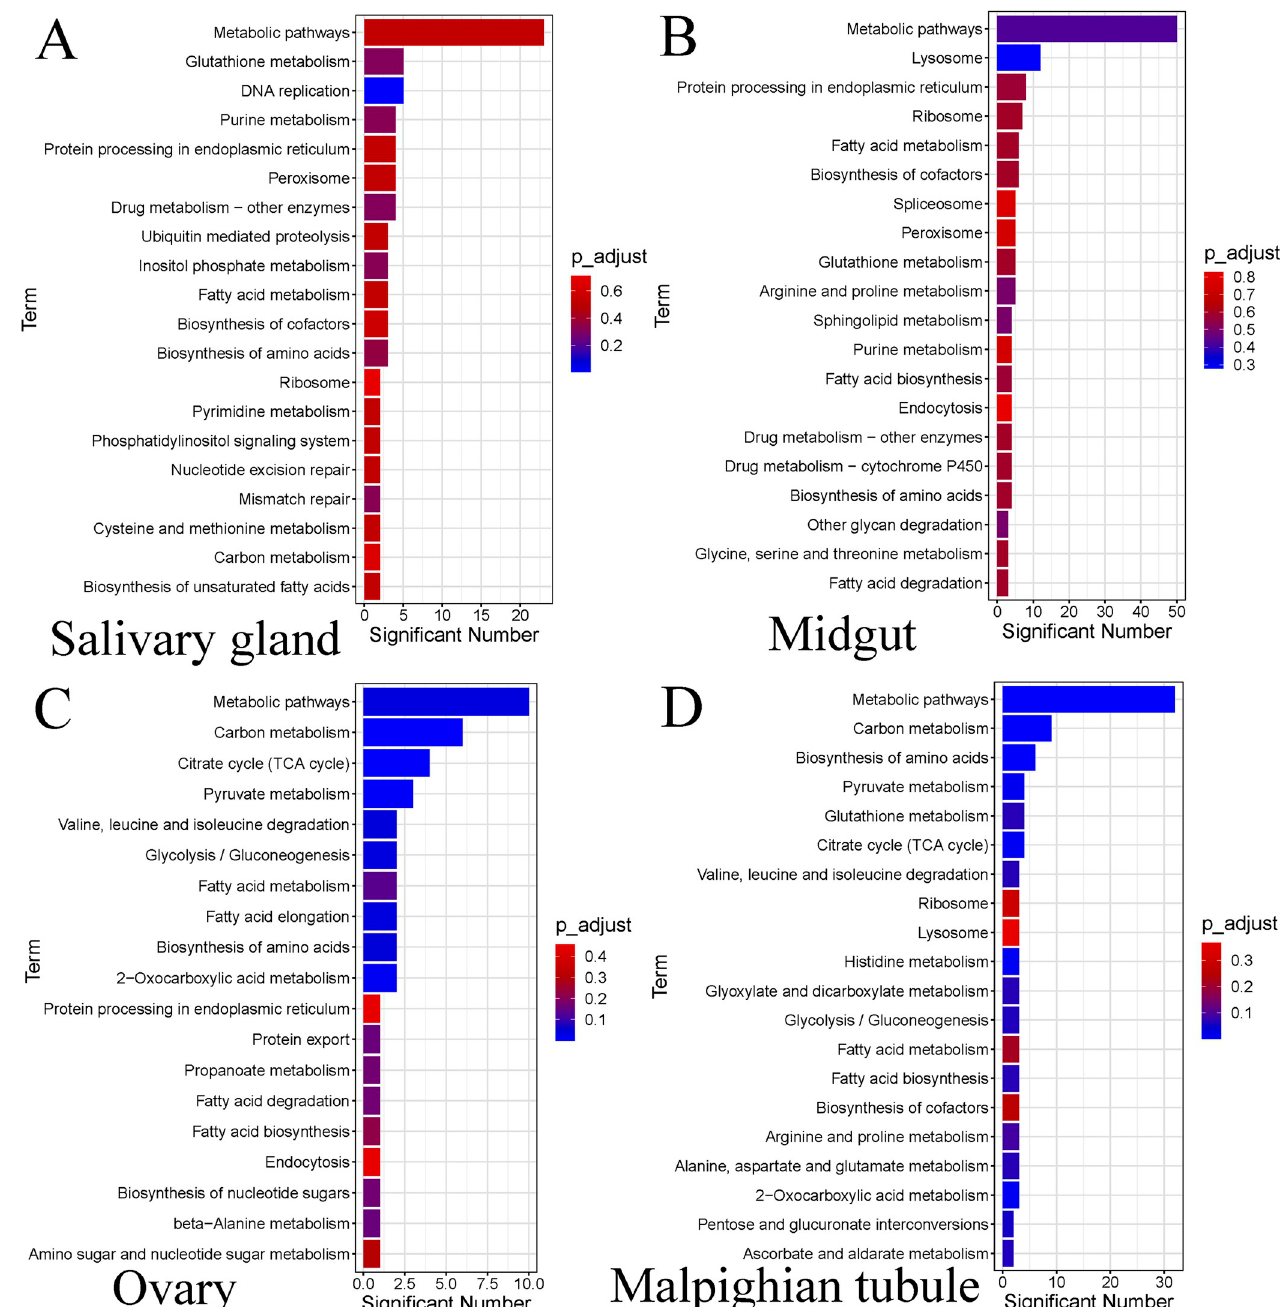
Fig 6. KEGG pathway enrichment analysis of differentially expressed proteins in four tissues of female H . longicornis at different stages of starvation. Significant Number represents the number of proteins in each pathway. A. Salivary glands, B. Midguts, C. Ovaries, D. Malpighian tubules. https://doi.org/10.1371/journal.pntd.0010692.g006 adaptation involving elevated rate of lipolysis, ketogenesis, increased hepatic fatty acid oxida- tion, and reduced uptake of glucose and oxidation in peripheral tissues as observed in long- term starved Sparus aurata [30]. A similar phenomenon also occurred in the long-term starved tick D . marginatus . In the study of the long-term starved tick D . marginatus , the transcription